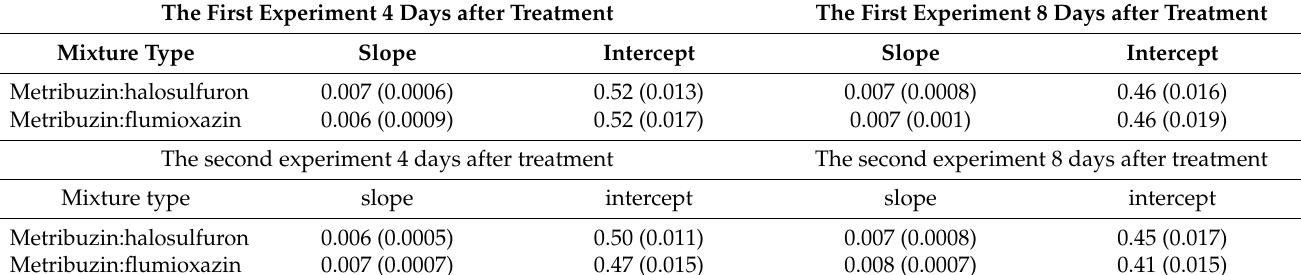
Table 5. Estimated linear regression parameters for F v /Fm on biomass (Figures 6 and 7) metribuzin:halosulfuron and metribuzin: flumioxazin on days 4 and 8 after treatment for the two independent experiments. Standard errors in